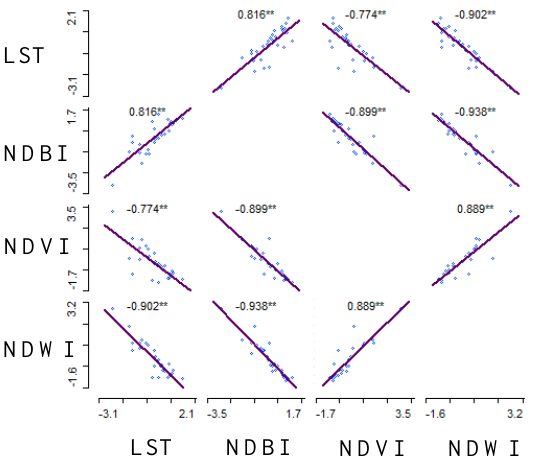
Figure 8. Relationship between LST and other indices with its corresponding slope of linear fit